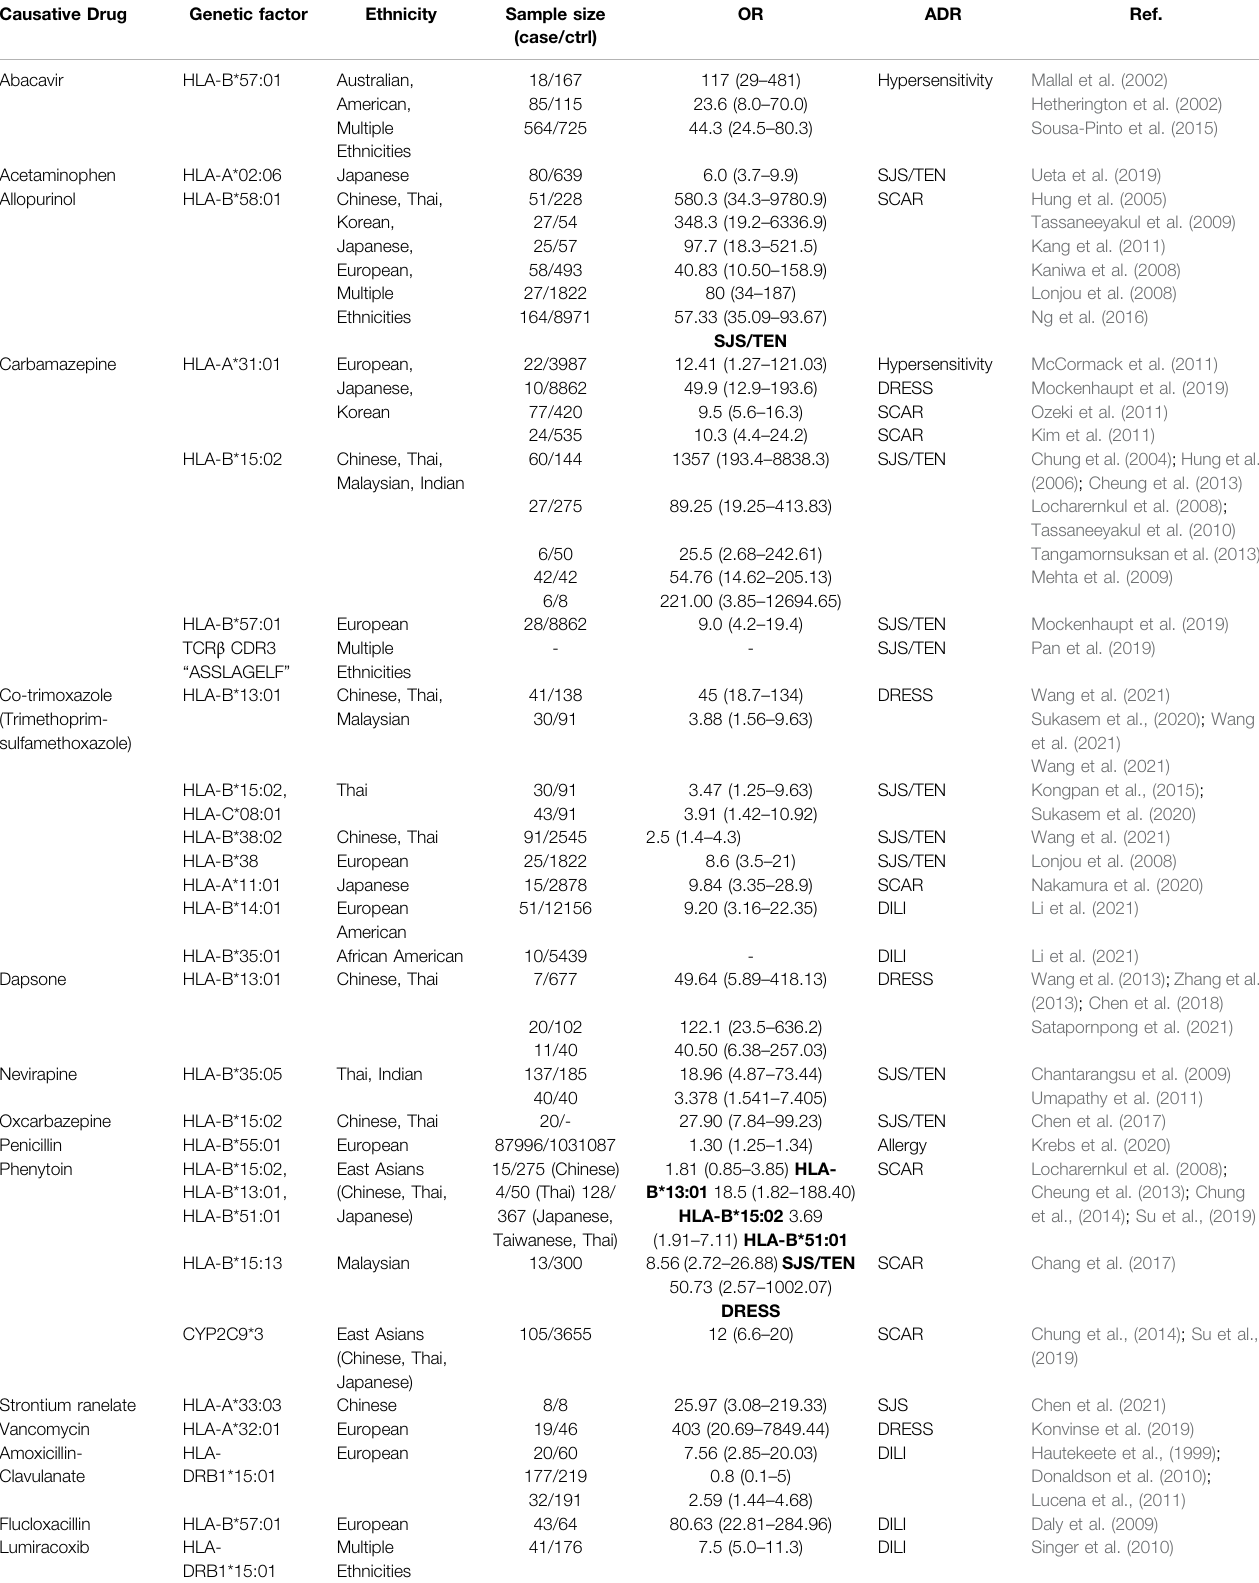
TABLE 1 | Genetic associations with severe ADR in HLA, TCR, drug metabolism enzymes, and drug transporters. Causative Drug Genetic factor Ethnicity Sample size